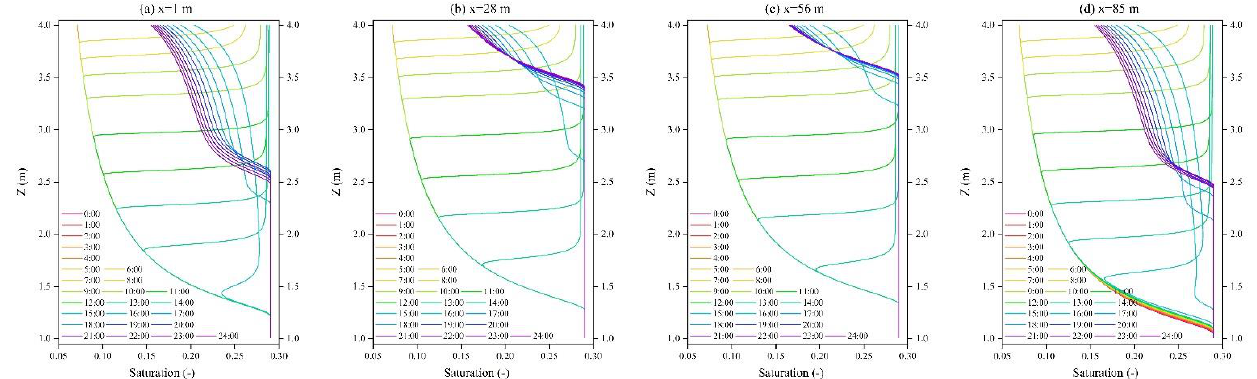
Figure 14. Vertical saturation distributions of at different horizontal positions: ( a ) x = 1 m; ( b ) x = 28 m; ( c ) x = 56 m; ( d ) x = 85 m for the BJH case.